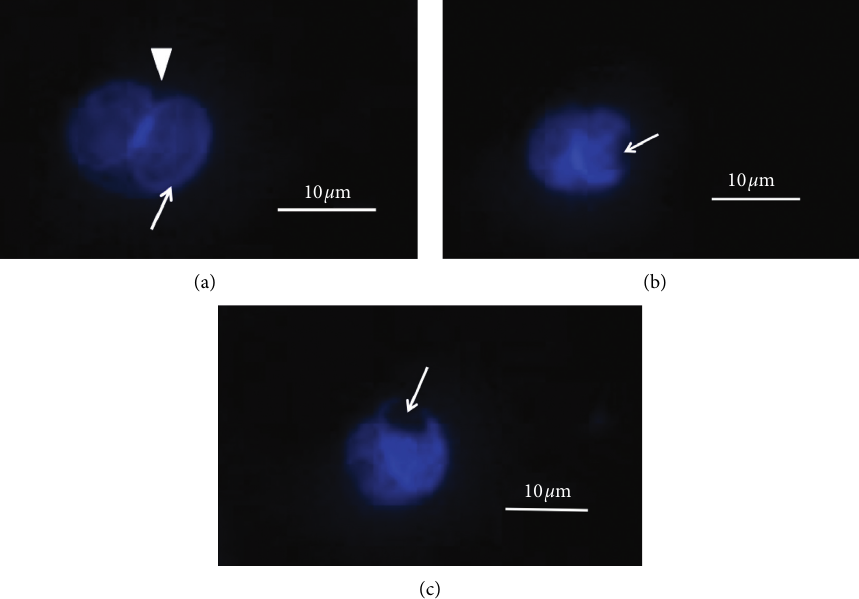
Figure 2: Effect of AgNPs in Toxoplasma gondii morphology as assessed by fluorescence microscopy. In the control sample, intact oocyst (a), in the presence AgNPs at 45 min (b) and 60 min